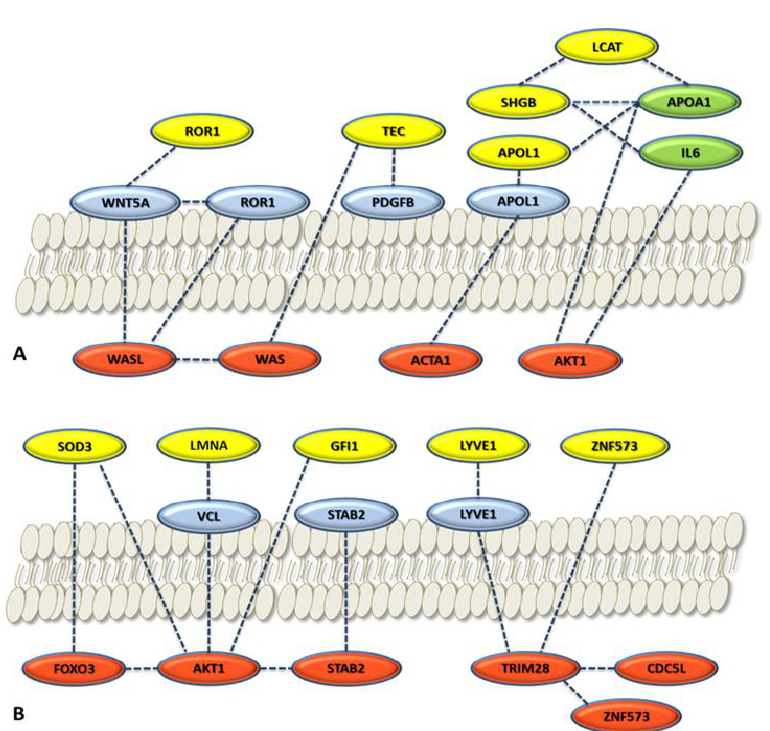
Figure 6. Local network connections for cytoplasmatic proteins (red), membrane proteins (blue), and serum proteins (yellow and green). The selected proteins of the panel were considered: ( A ) Panel proteins considered are ROR1, TEC, SHBG, LCAT, and APOL1; ( B ) panel proteins considered are SOD3, LMNA, GFI1, LYVE1, and ZNF573. Yellow circles, panel proteins selected; light green circles, relevant serum proteins for ovarian cancer in the network. Localization is based on GeneCards. The proteins reported not belonging to the panel come from the STRING local network analysis and GeneCards elaboration (Figure